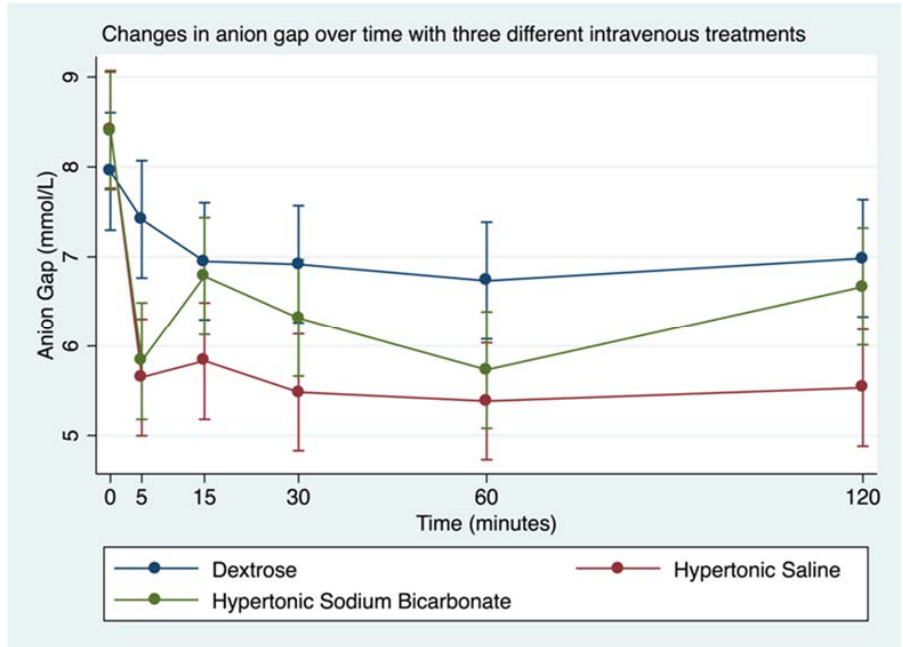
Figure 5. Overall effect of treatment on the blood AG over time. The mean and SEM venous blood AG for all six horses. Blue = Treatment Group DS (5% dextrose solution at 2 mL/kg bwt); Green = Treatment Group HB (NaHCO 3 8.4% solution at 2 mmol/kg bwt); and Red = Treatment Group HS (NaCl 7.5% solution at 4 mL/kg bwt).